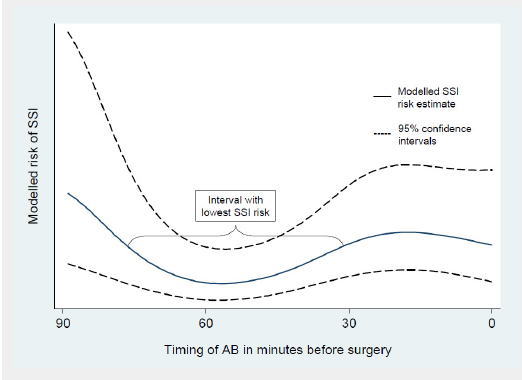
Risk of surgical site infection by timing of surgical antimicrobial prophylaxis. The lowest risk of surgical site infection was observed when the antibiotics were administered between 74 and 30 minutes before surgery.